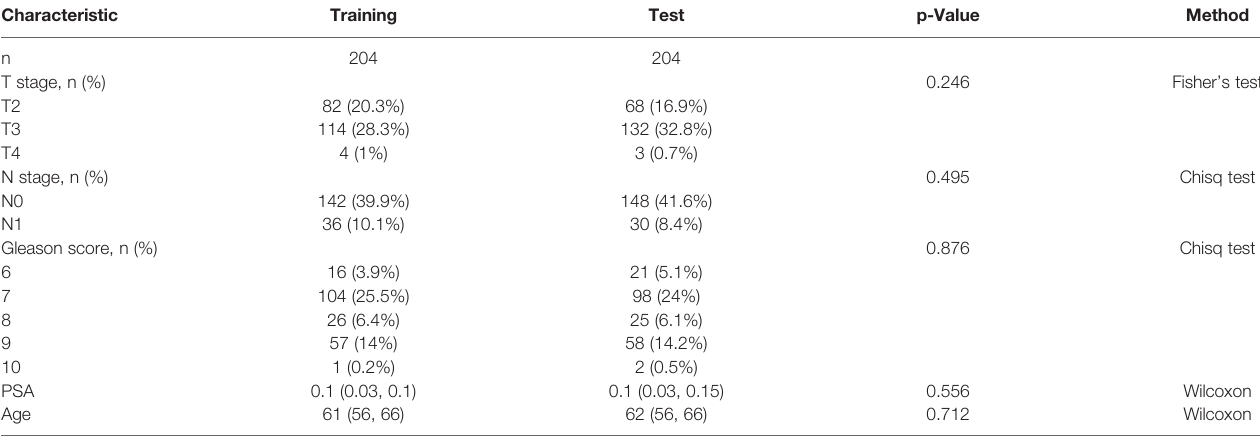
TABLE 1 | Difference analysis of clinicopathological characteristics between the training set and test set. Characteristic Training Test p-Value Method